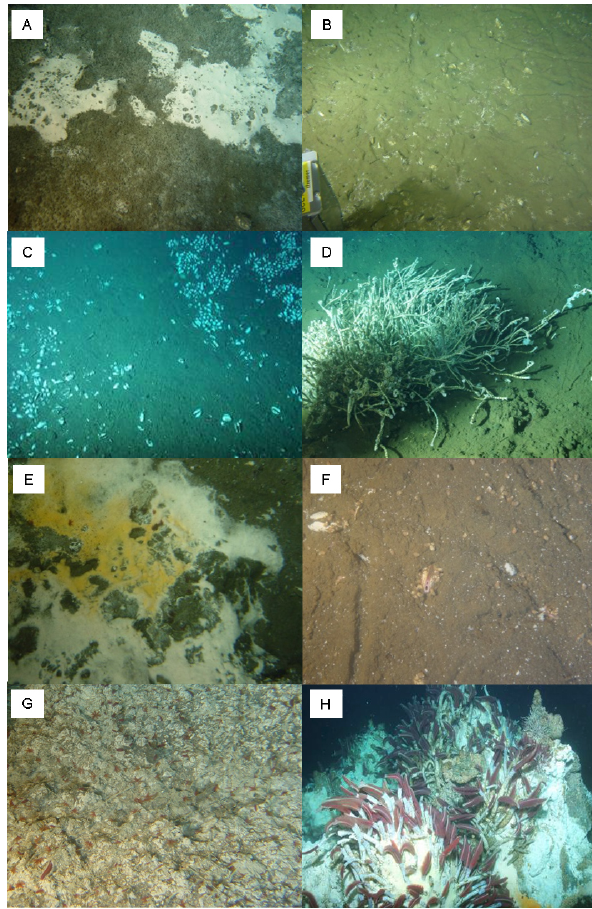
Figure 2. Images of studied assemblages at seeps: (a) S_Mat and S_Gast, (b) S_VesA, (c) S_VesP, (d) S_Sib and S_Sib_P and vents: (e) V_Mat, (f) V_VesA, (g) V_Alv and (h)